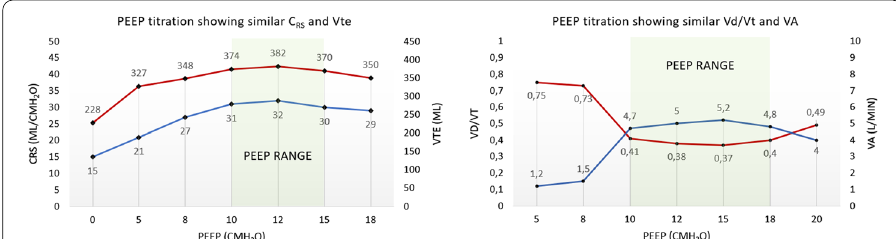
Fig. 1 PEEP titration using constant inspiratory pressure of 14 cmH 2 O during pressure-controlled ventilation (PCV) in two different passive severe COVID-19 ARDS patients. Colored boxes are pointing out similar